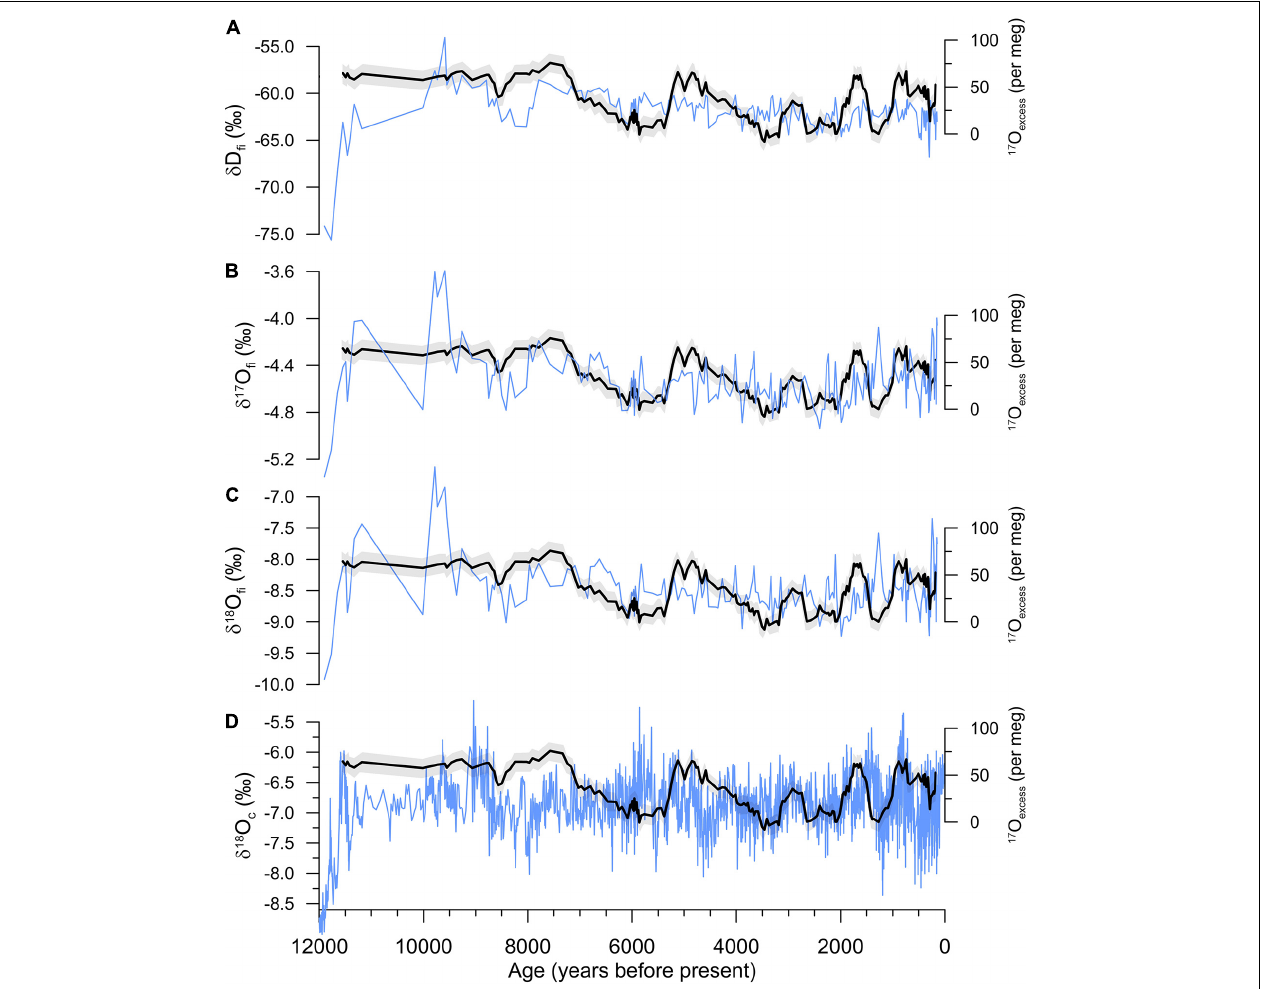
FIGURE 8 | Comparison of 17 O excess values and uncertainties (black lines and gray areas) with other published records coming from the same stalagmite over the past 14,000 years (Affolter et al., 2019). The 17 O excess record (9 value running average) is shown with the corresponding fluid inclusion δ D fi (A) , δ 17 O fi (B) , δ 18 O fi (C) values and the calcite δ 18 O c (D) full record (all blue